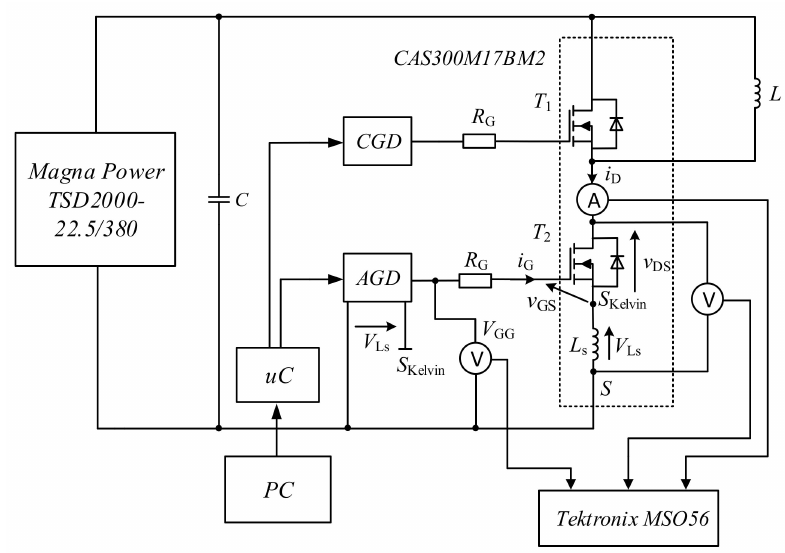
Figure 8. Experimental setup of the DPT with a medium-voltage (MV) SiC MOSFET CAS300M17BM2 module.